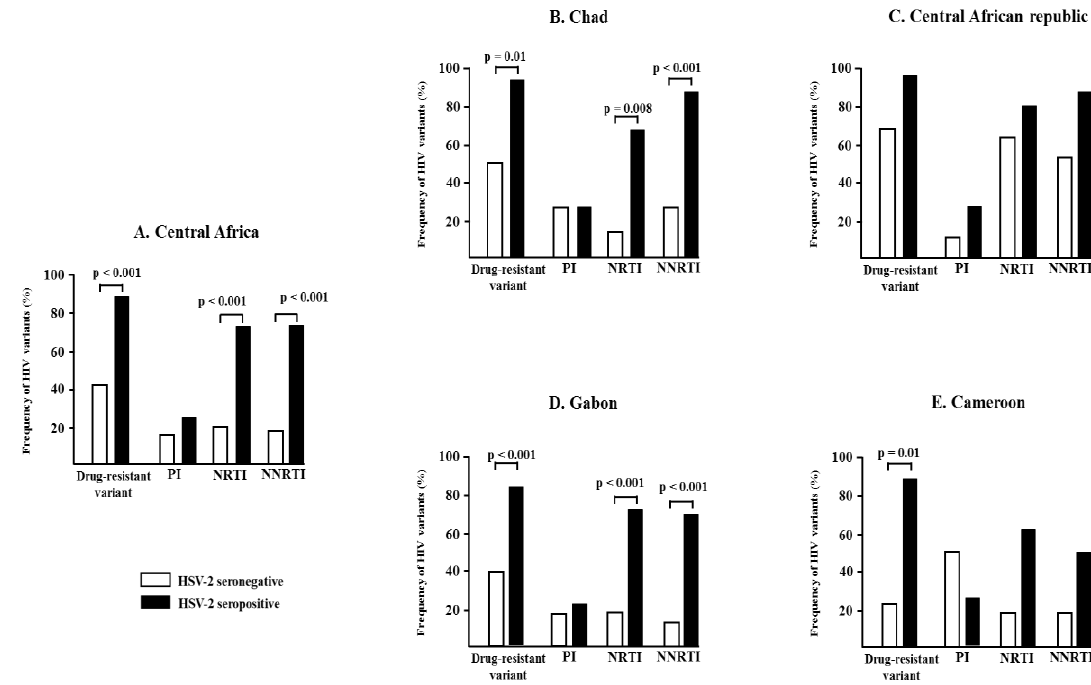
Figure 4. Frequency of ARV resistance mutations according to HSV-2 seropositivity.